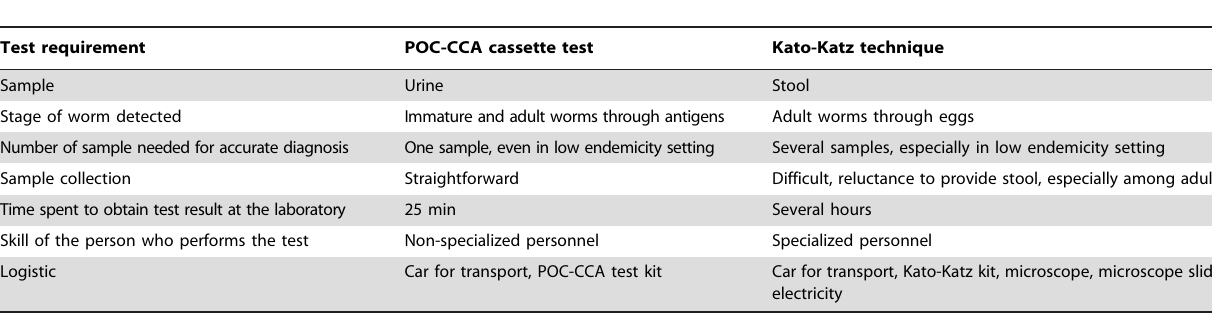
Table 6. Comparison of test requirements of POC-CCA cassette test and Kato-Katz